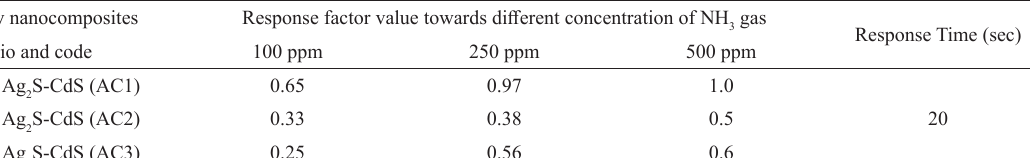
by PPy/(Ag S:CdS) hybrid nanocomposites. 3 2 gas 3 Response Time (sec)